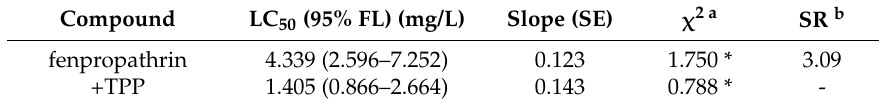
Table 1. Synergistic effects of TPP on fenpropathrin against P. citri of BB population.